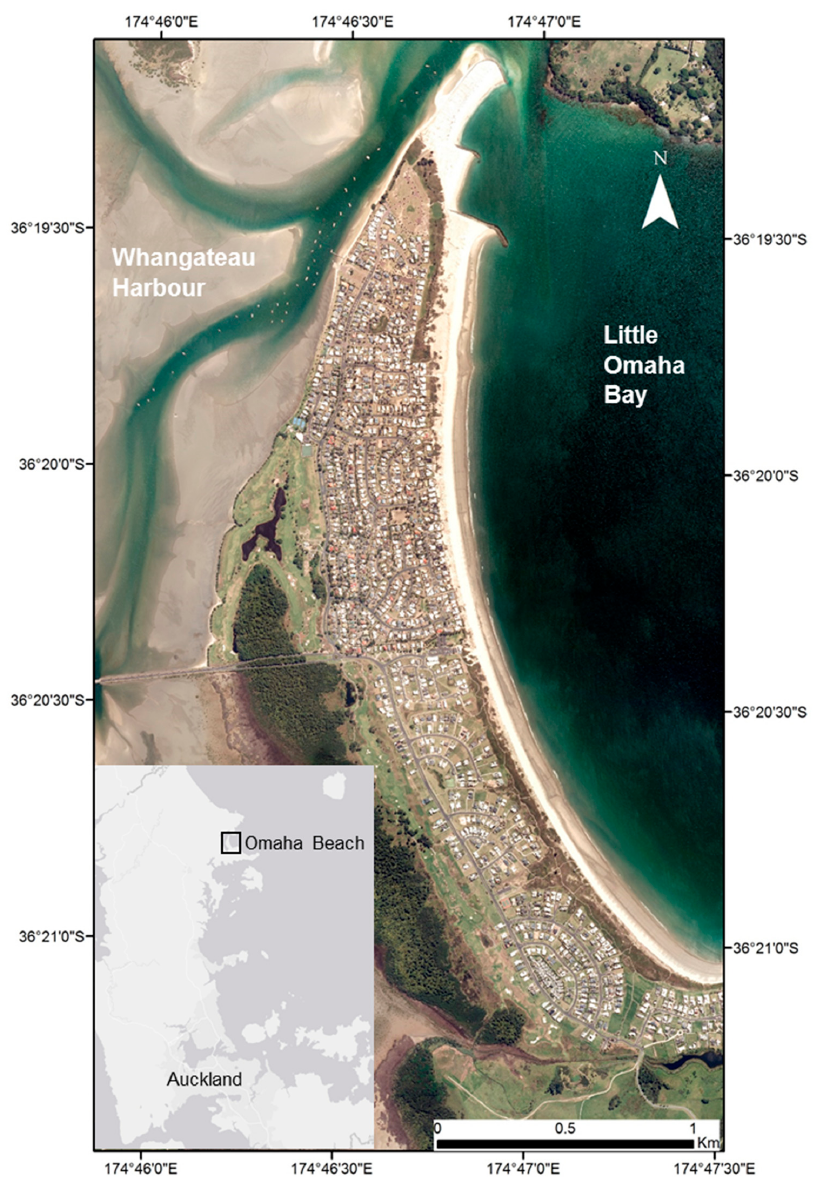
Figure 1. Overview of study location and urban settlement at Omaha Beach in 2012.